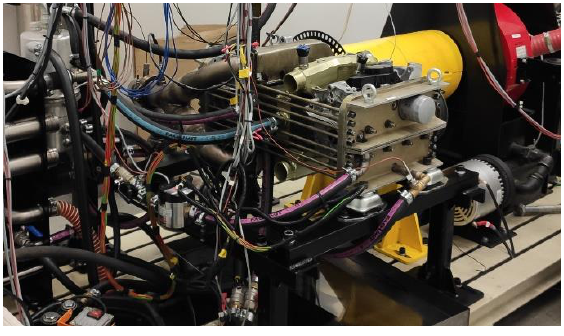
Fig. 2. PZL-100 engine on the test stand